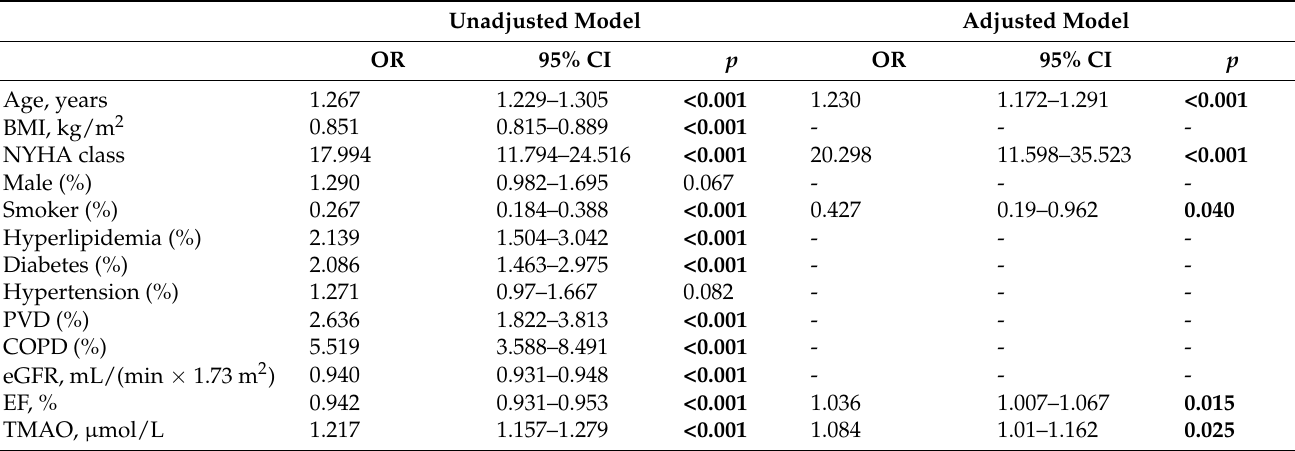
Table 2. Association between clinical characteristics and aortic stenosis by logistics regression. Unadjusted